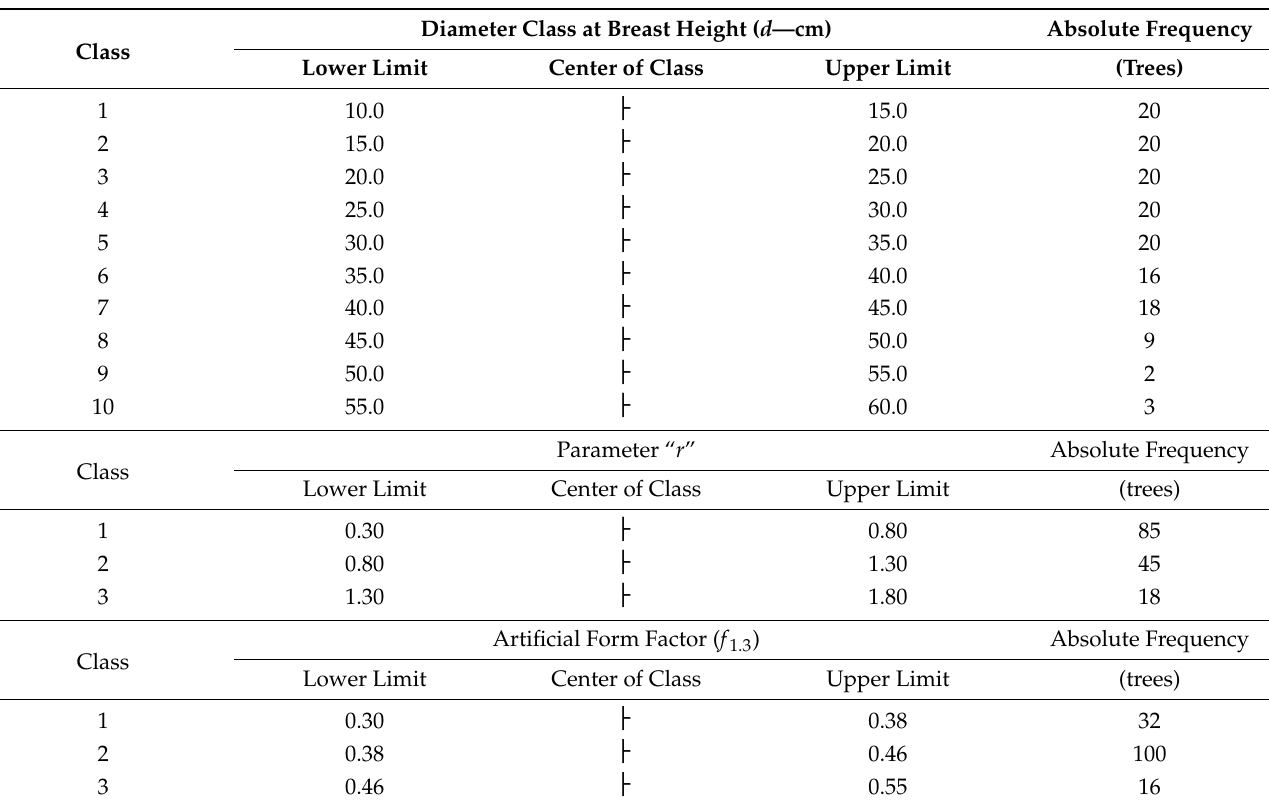
Table 3. Stratification proposed by the diameter class at breast height, by parameter class “ r ” and by artificial form factor class for Tectona grandis L.f. scaled trees, central-west region, Brazil .